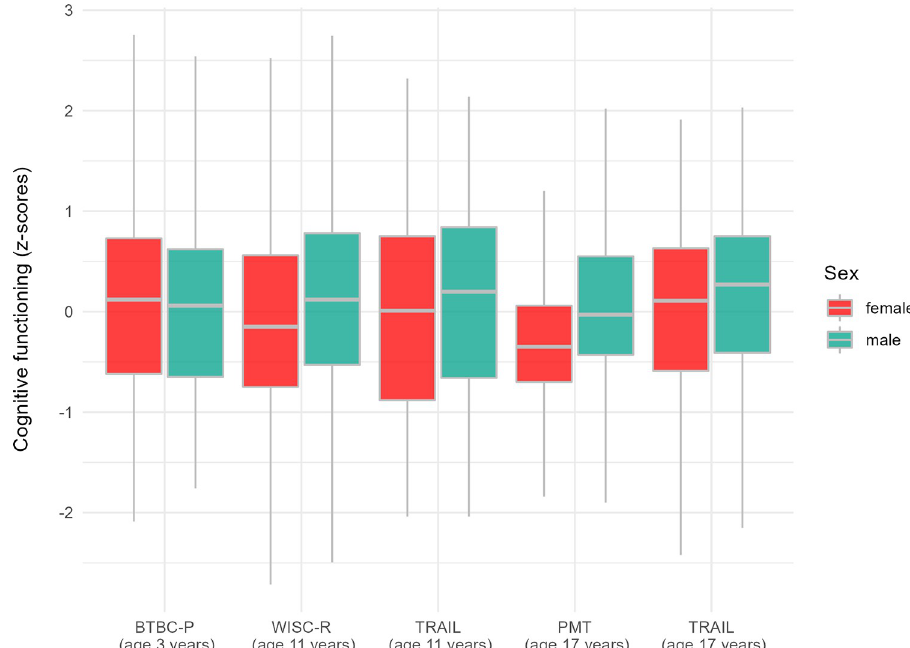
Fig 3. Summary of cognitive functioning indicators for males and females at ages 3, 11, and 17 years based on imputed data.